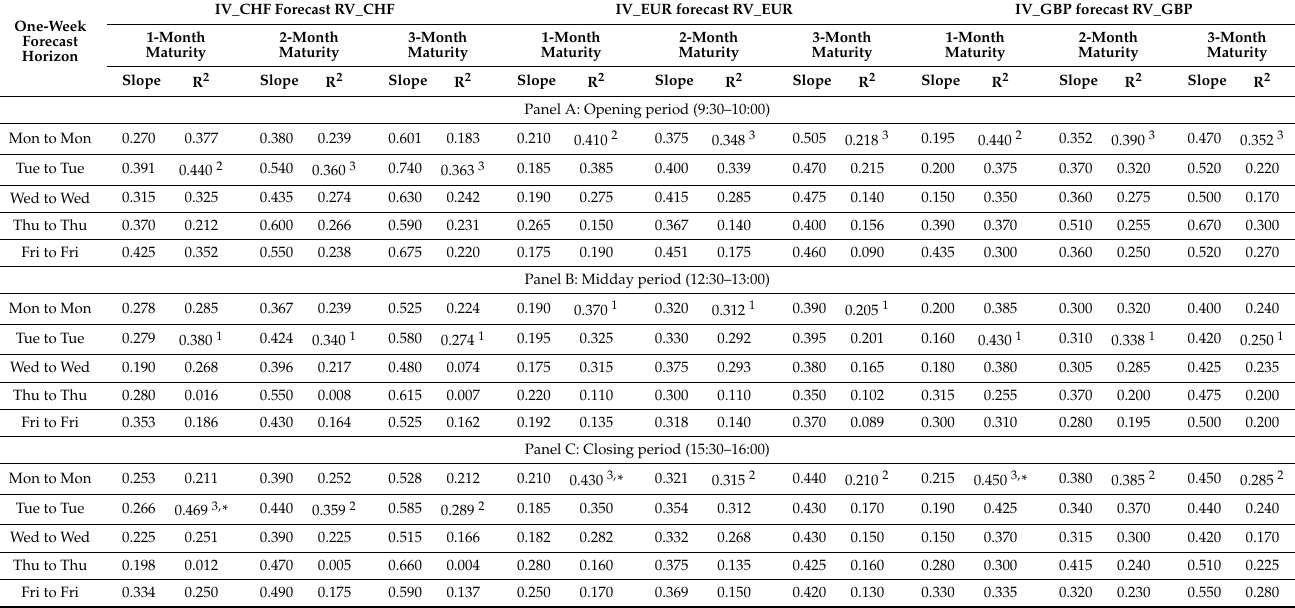
Table 2. IV forecast RV for the one-week